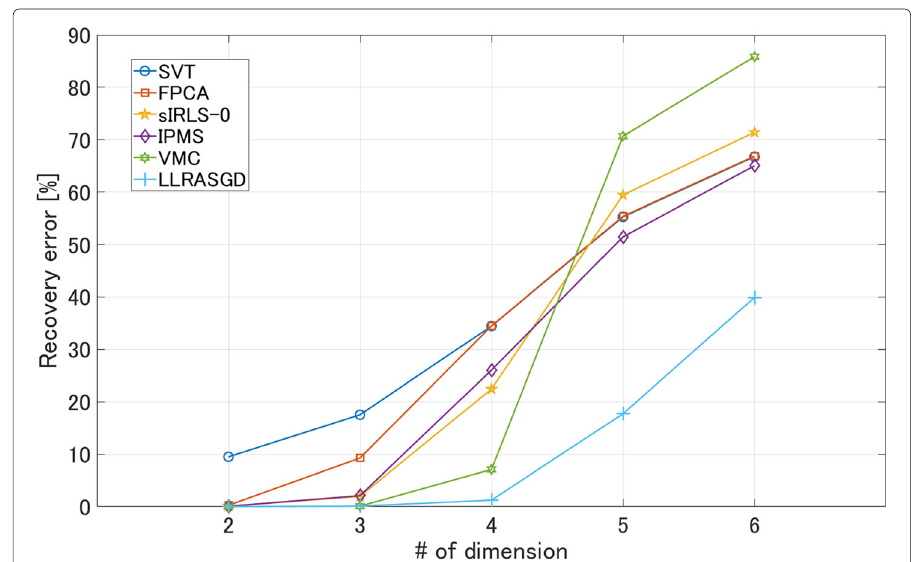
Fig. 2 Average RE for 10 trials with p = 3 for (20) and q = 0.3